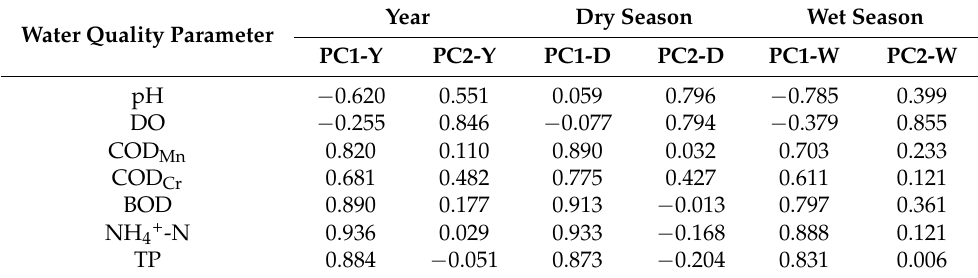
Table 5. Initial factor loading